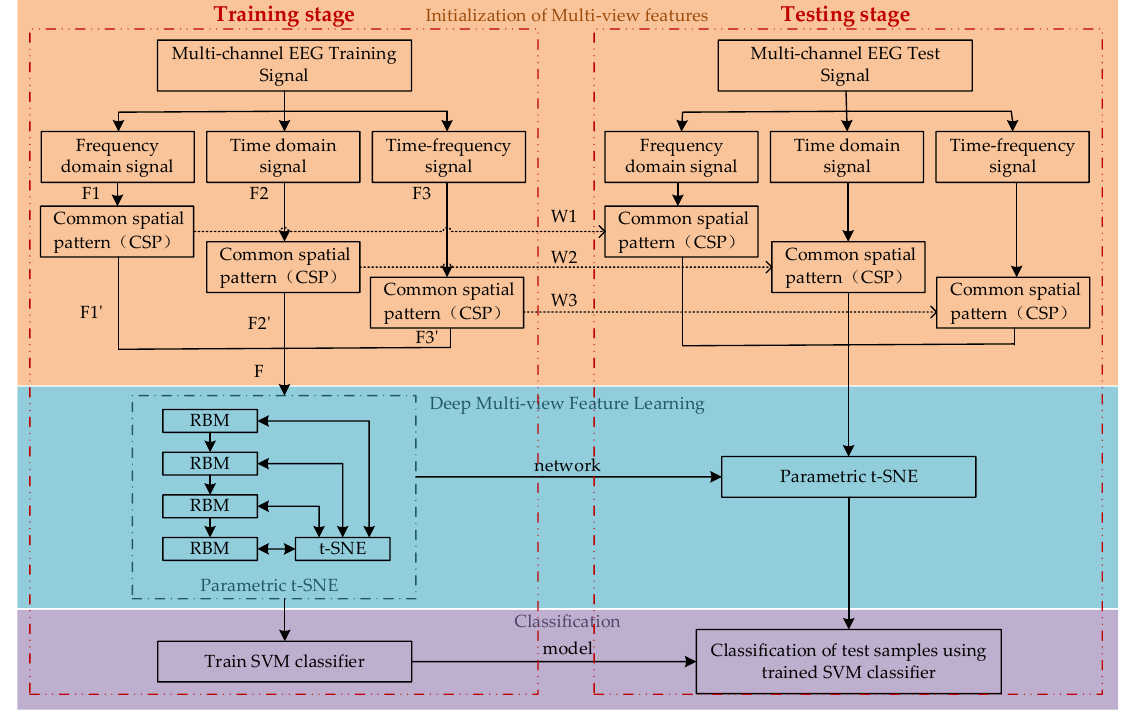
Figure 1. Framework of the proposed method.